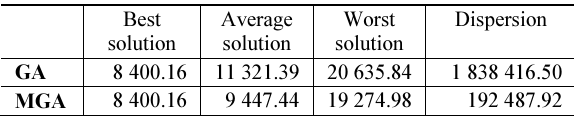
Table 7. Statistical indicators of solutions Best